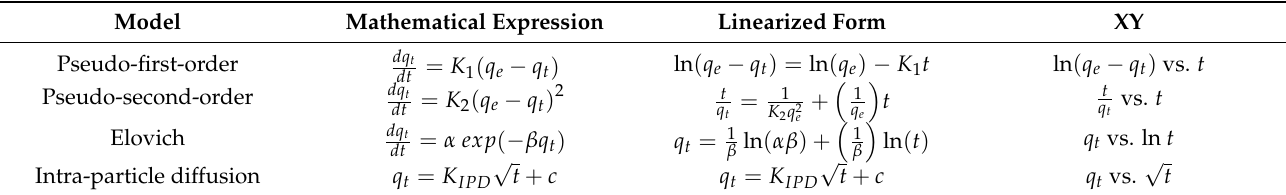
Table 1. Adsorption kinetic models used in the